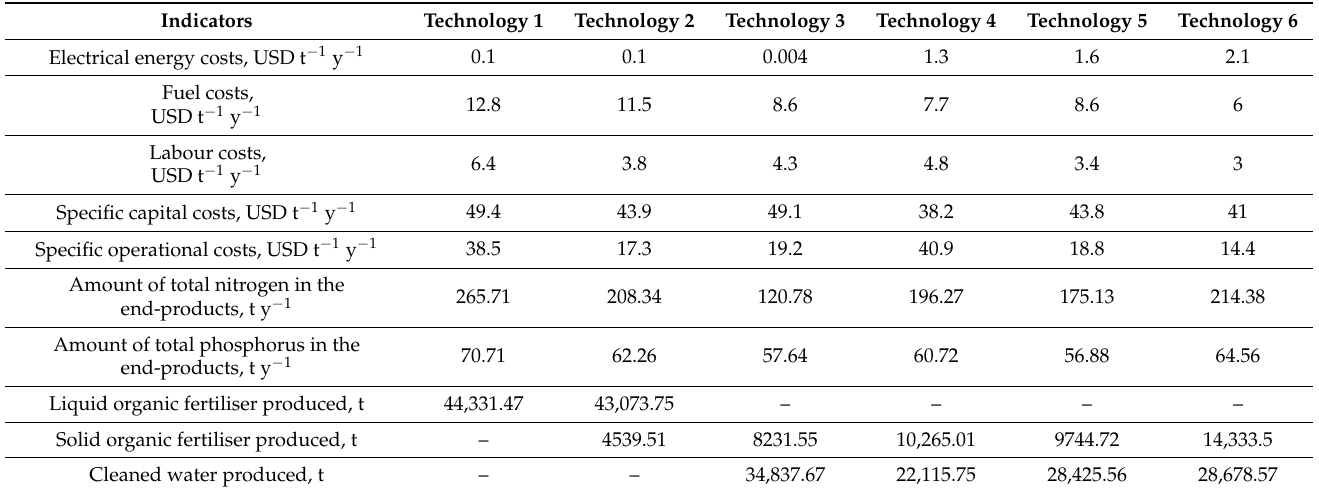
Table 1. Estimated economic and ecological indicators of obtaining the end-products on the pilot pig farm.